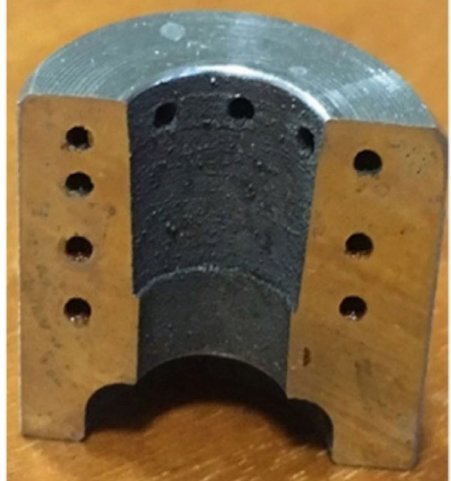
Figure 21. An extrusion die insert with conformal cooling channels through which liquid nitrogen flow. This die insert was made by L-PBF in H13 and integrated into a conventionally machined steel housing [134]. The height = 20 mm and the outer diameter = 25 mm [135].